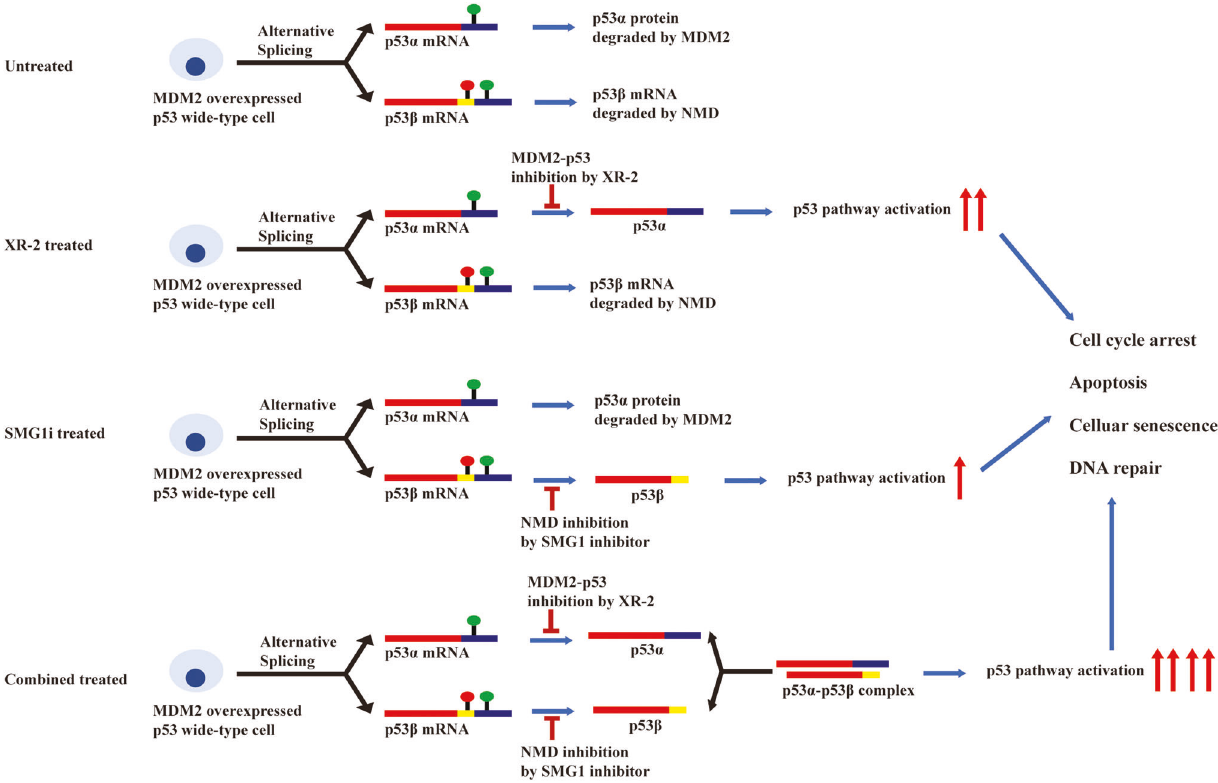
Fig. 7 The mechanism of nonsense-mediated mRNA decay inhibition synergizes with MDM2 inhibition to suppress TP53 wild-type cancer